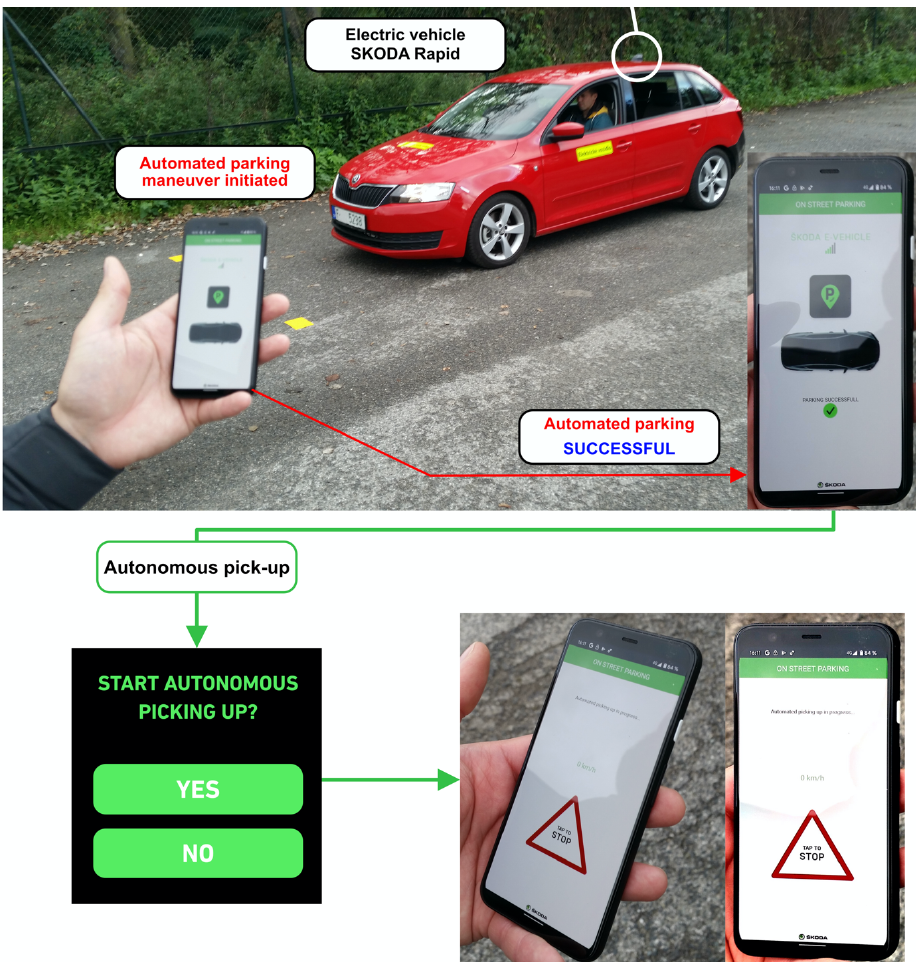
Figure 11. Testing scenario